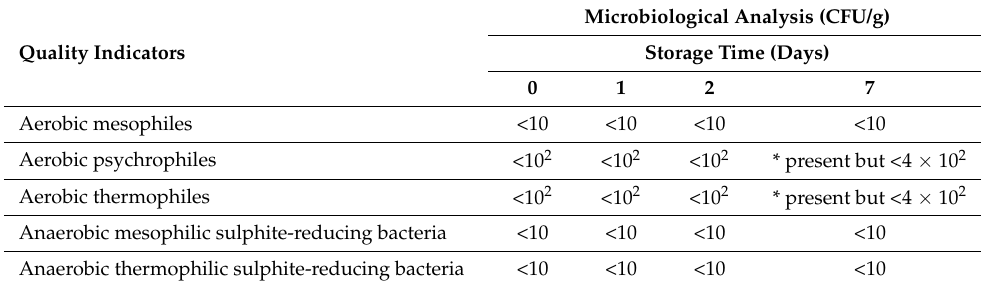
Table 4. Microbial quality of canned sardines in light brine, in vegetable oil and in tomato sauce during storage at 4 ◦